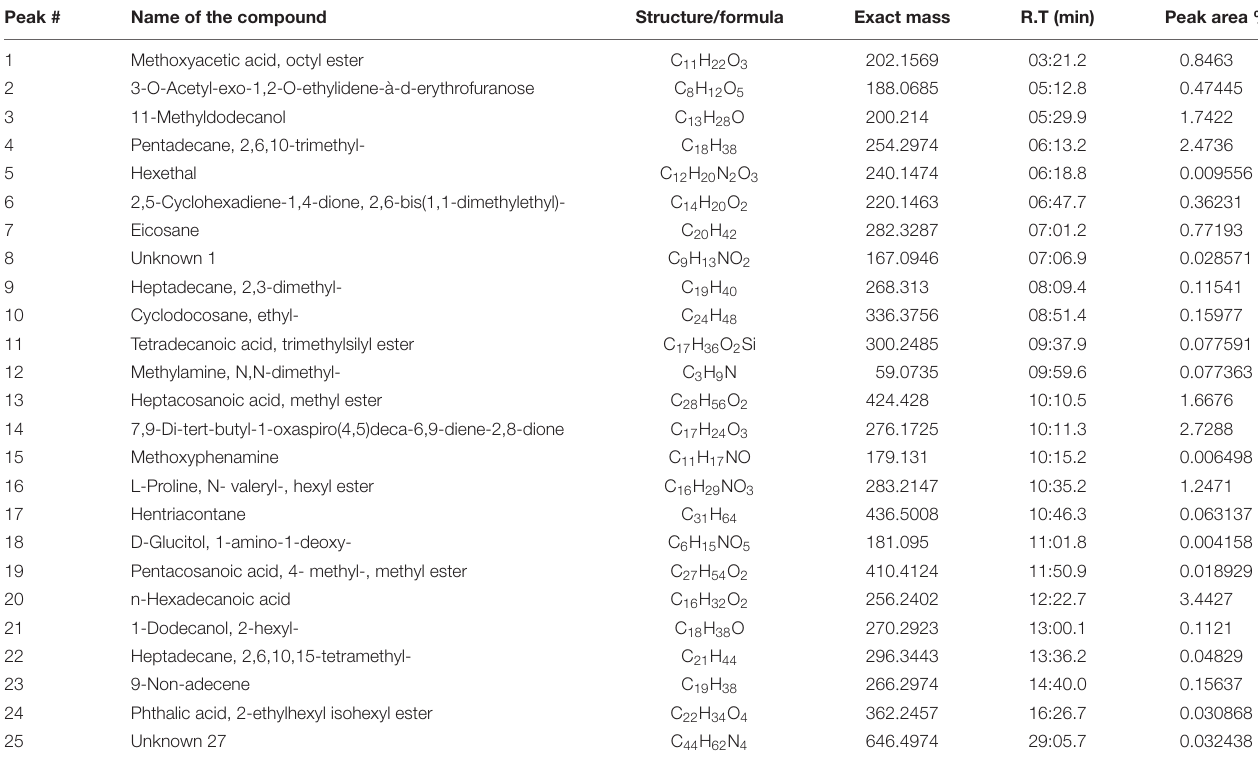
TABLE 1 | Secondary metabolites identified in crude secondary metabolite extract from D. radiodurans . Peak # Name of the compound Structure/formula Exact mass R.T